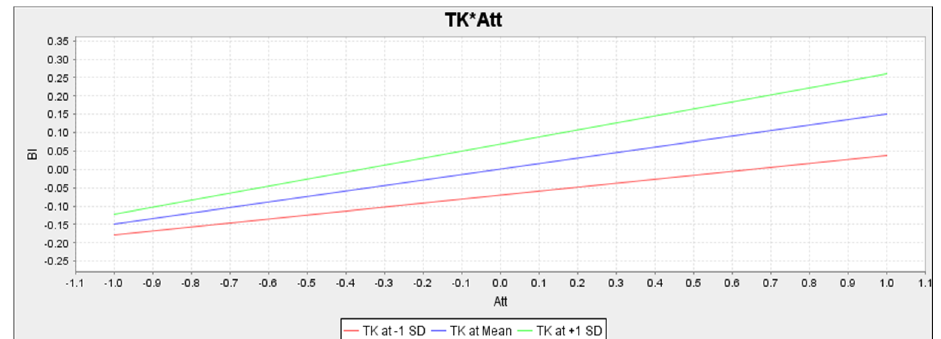
did not mediate the association between perceived ease of use and behavioral intention